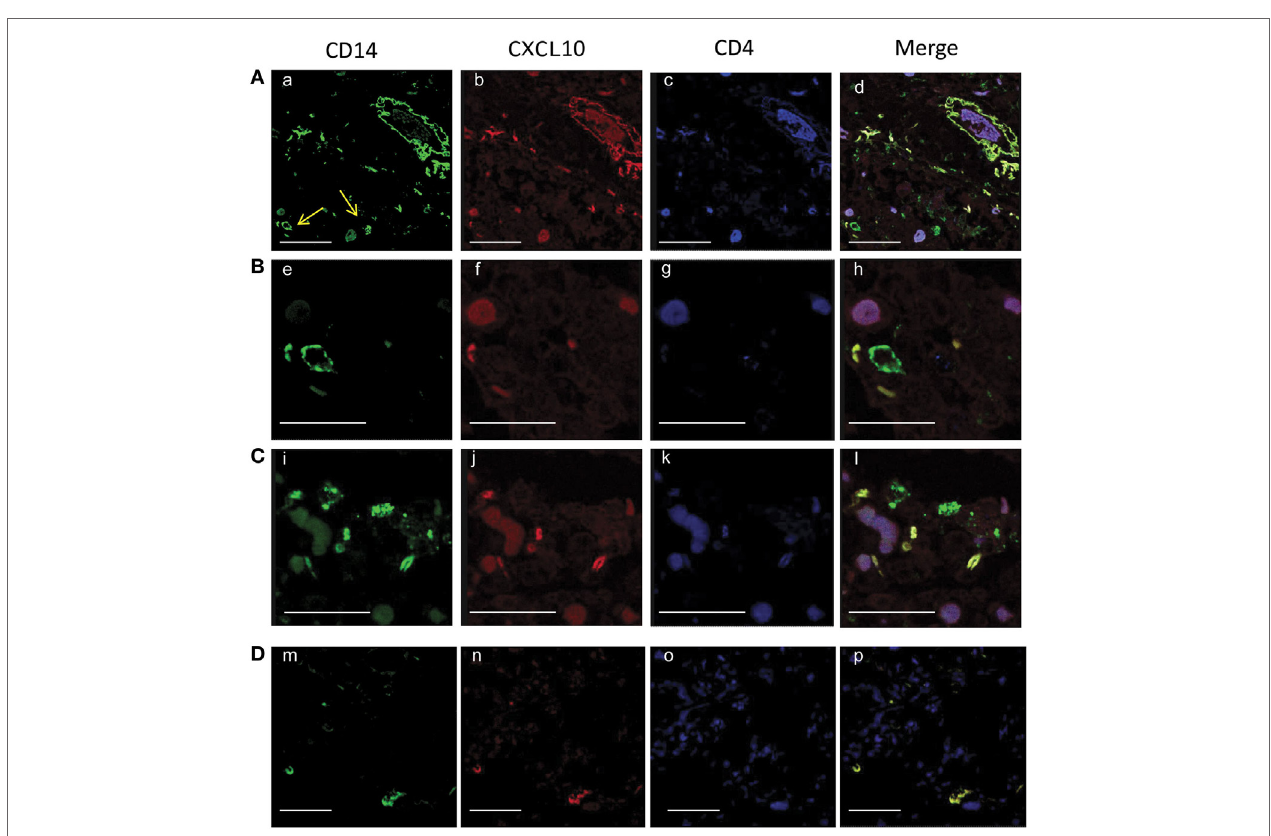
FigUre 8 | Confocal microscopy analysis of CXCL10 expression in tuberculosis (TB) [lines, (a–c) ] and control [line, (D) ] samples. Lung sections were stained with anti-CD14 (a, e, i, m, green), with anti- CXCL10 (b, f, j, n, red), and with anti-CD4 (e, g, k, o, blue). In TB samples, the merged images of the triple-fluorescence signals (d, h, l, m erge) highlights the expression of CXCL10 in CD4 + T lymphocytes (purple) presents in the inflammatory area and in macrophages (yellow); some CD14 + positive cells do not express CXCL10 (green). In controls, merged image (p) shows the CXCL10 expression only in CD14 + positive cells (yellow). Scale